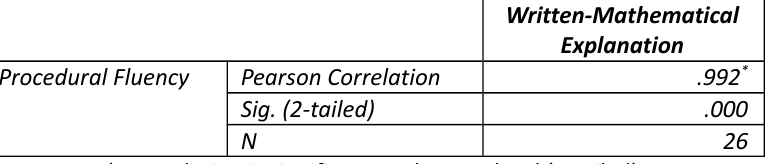
Table 2. Relationship of the Students’ Procedural Fluency to